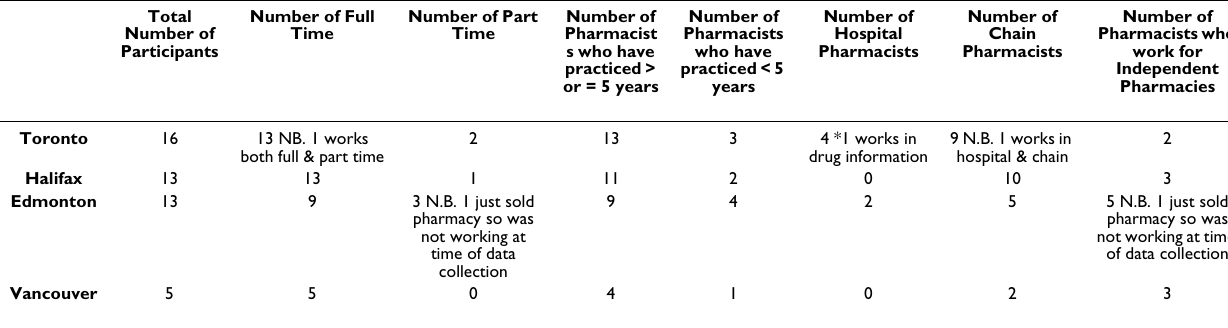
Table 1: Summary of Pharmacists' Demographics